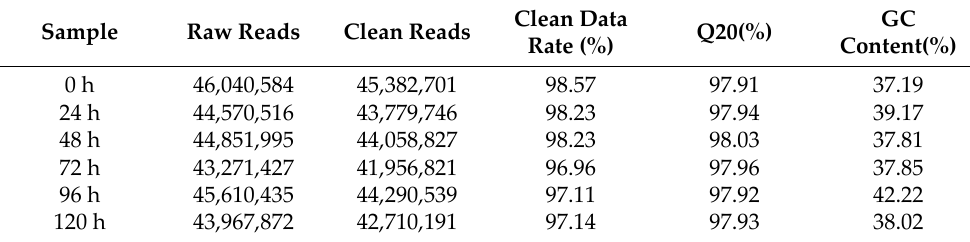
Table 1. Summary of basic statistics for the W. anomalus YF1503 transcriptome sequencing